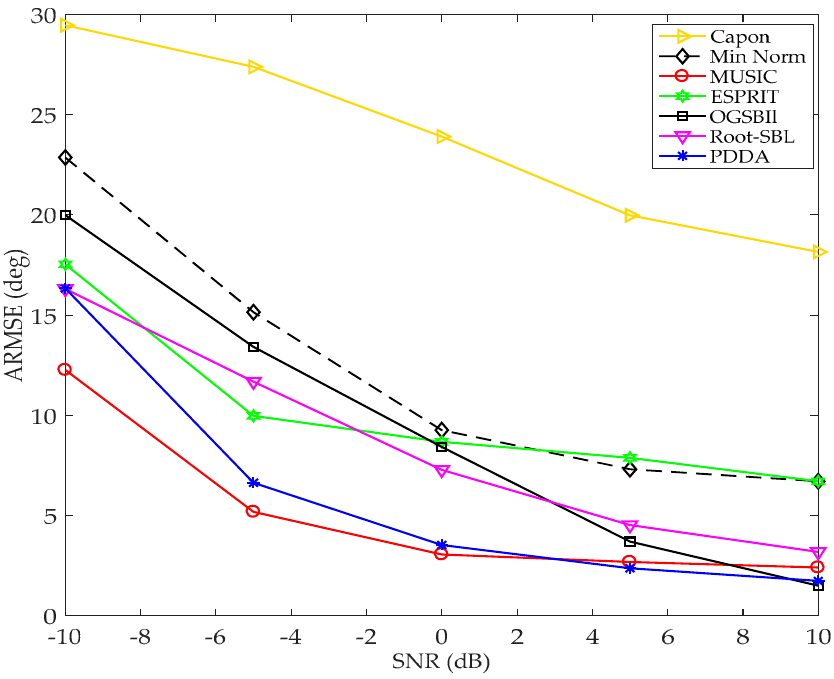
Figure 8. ARMSE vs. SNR, with M = 8, D = 2, N = 3, 1000 Monto Carlo simulations for each SNR.